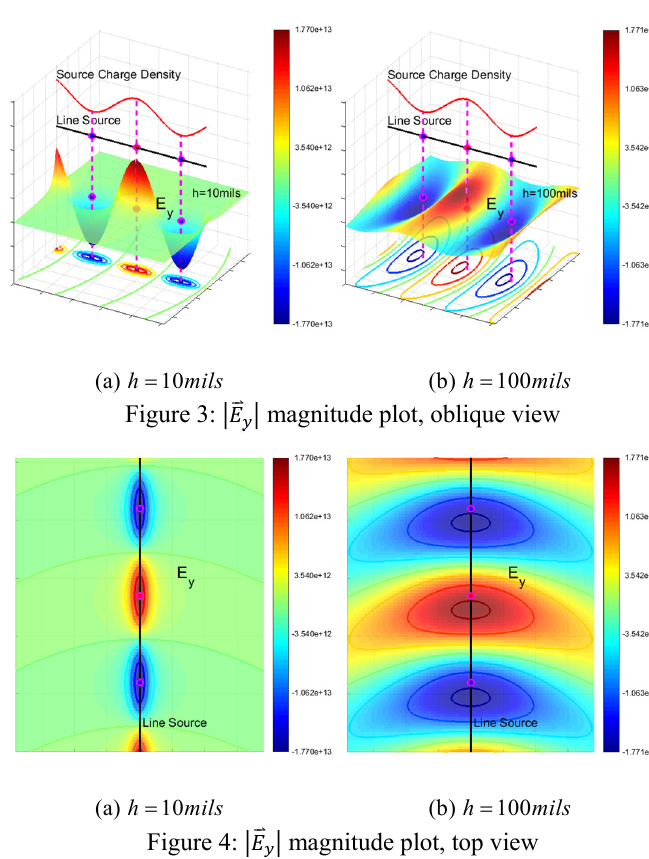
Figure 4: ⃑ magnitude plot, top view